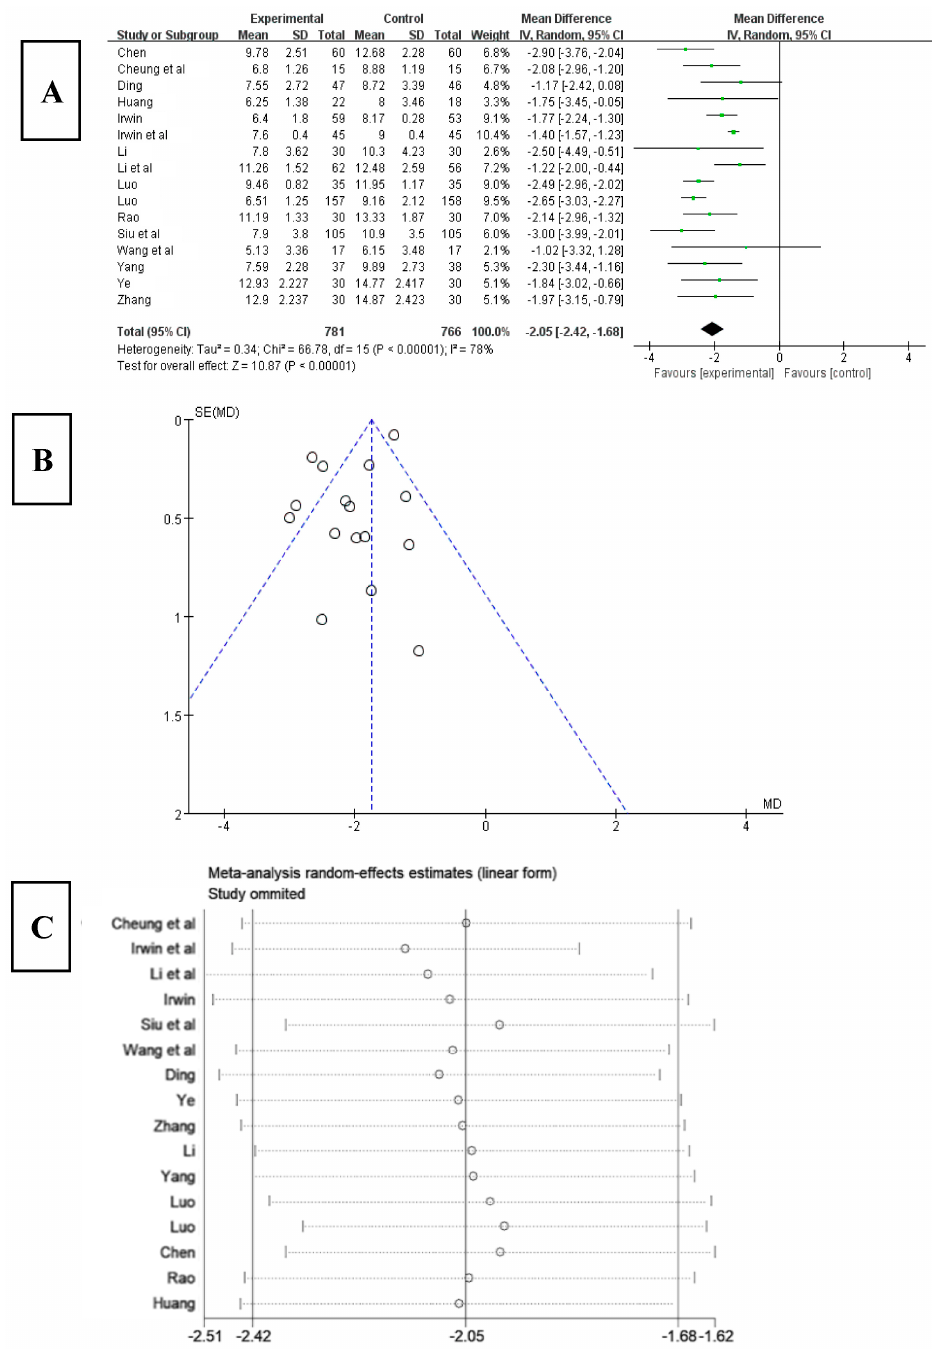
Figure 3 . ( A ) Forest plot of PSQI effect size. ( B ) PSQI meta-analysis funnel chart. ( C ) Sensitivity analysis of PSQI effect size.